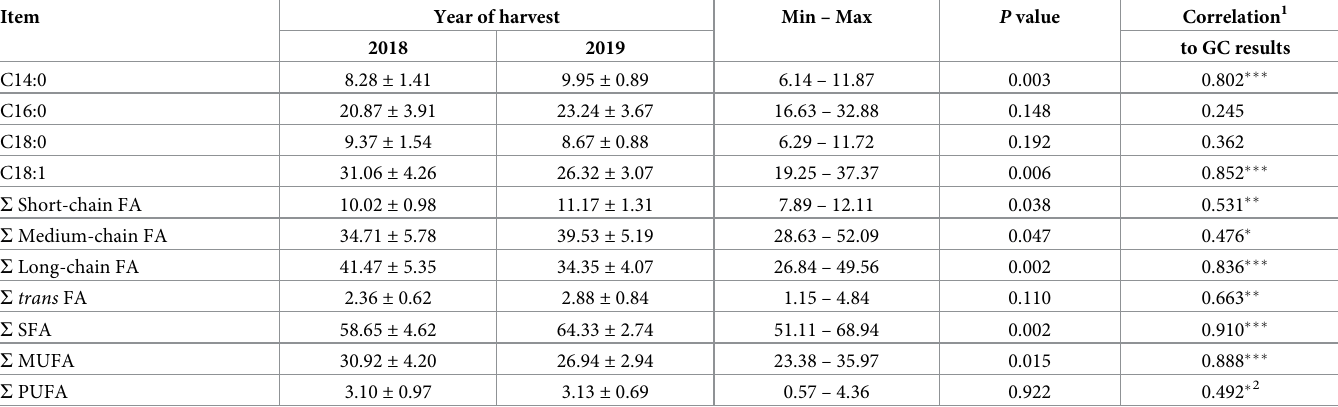
with the 2019 harvest (Table 1). The cows that were supplemented with β -carotene (triangled symbols) did not produce milk with a different color compared to the other cows (Fig 1G and 1H). Preliminary set of biomarker prediction values to determine the proportion of dietary grassland-based feeds As a first step towards the simplest determination of the proportion of grassland-based feeds in a dairy cow’s diet, the regression coefficients were omitted for the interaction between %GB and Year in the ALA equation and the interaction between %GB and Year, and DIM, in the a � color equation. This allowed for the development of a preliminary set of biomarker prediction values to determine the proportion of dietary grassland-based feeds when the more detailed Table 5. Effect of year of harvest of the grassland-based feeds on the proportions of individual fatty acids (FA) or groups of FA (g/100 g of total milk fat) in milk as estimated by MIR.